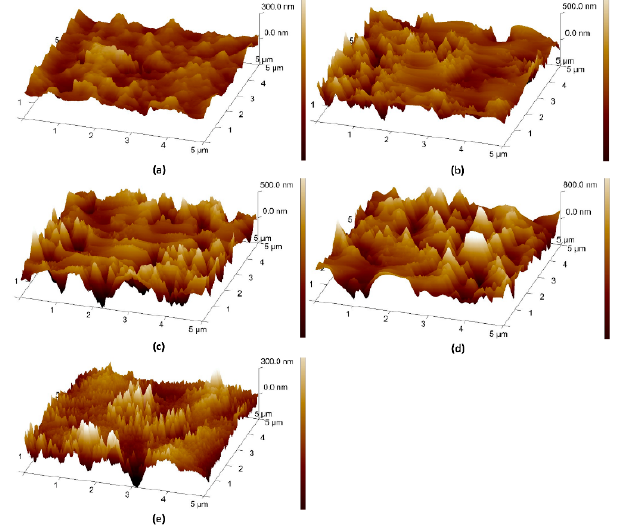
Figure 3. AFM scanning images of ( a ) step 1, ( b ) step 2, ( c ) step 3, ( d ) step 4 and ( e ) untreated. Table 6. Surface roughness variation during the RIE process.